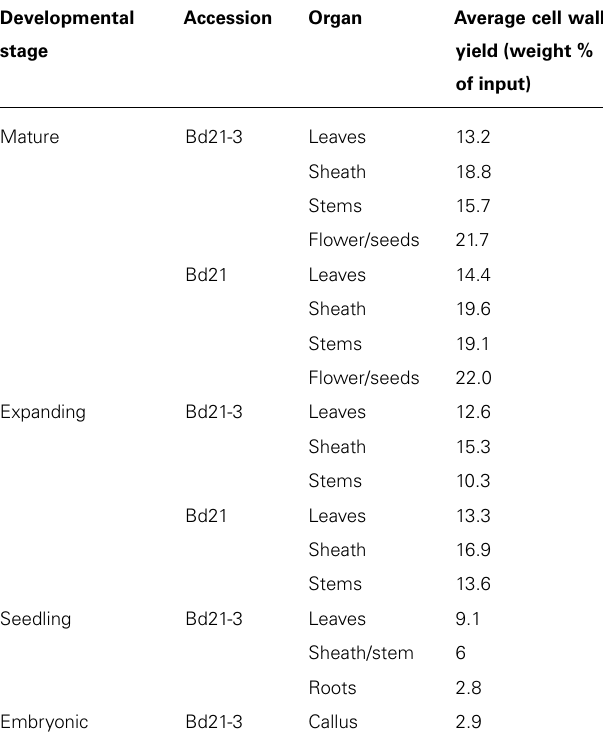
Table 1 |Average cell wall yields from developing Brachypodium distachyon